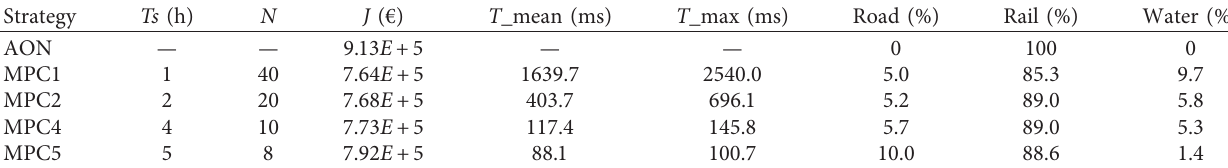
Table 3: Comparative experiment of different MPC